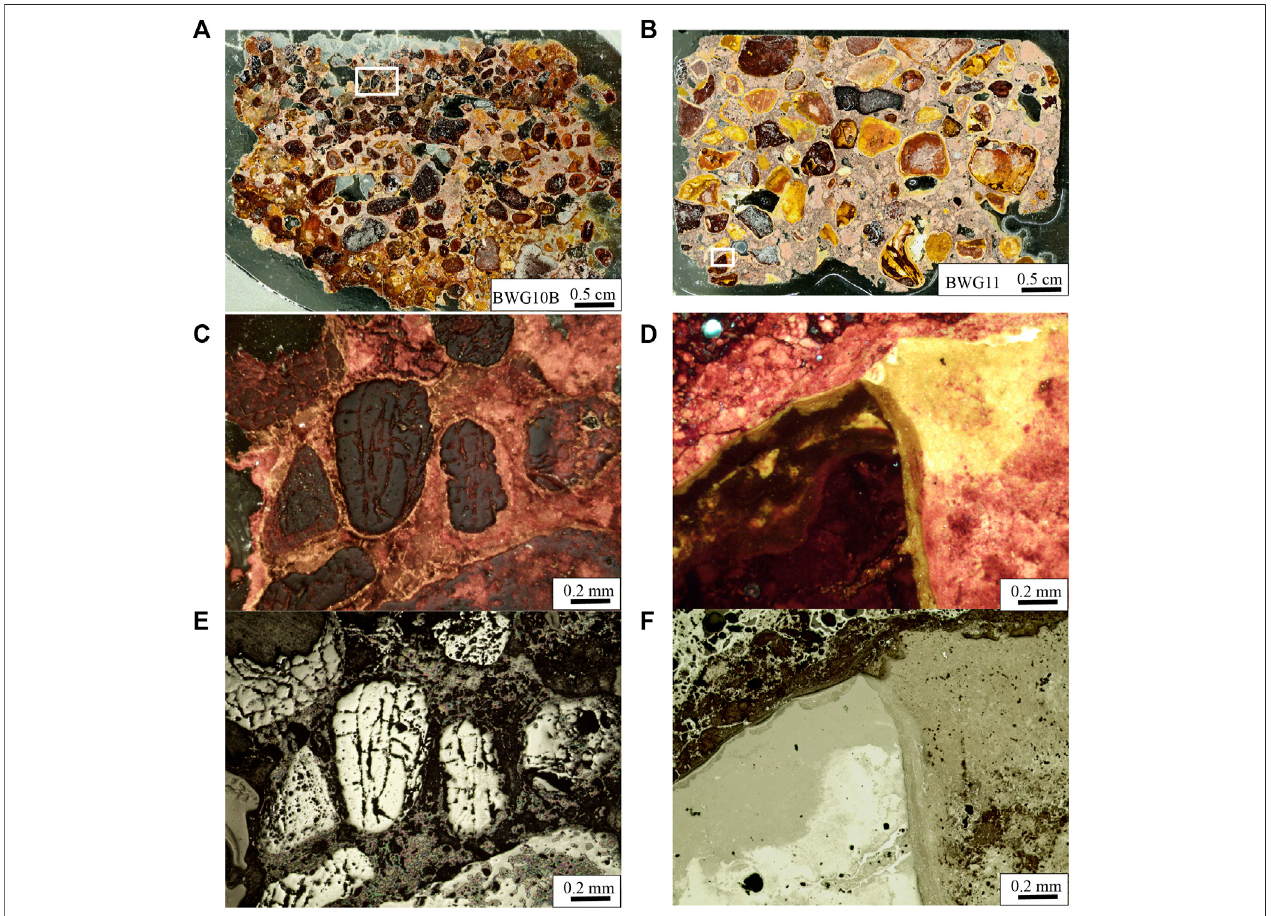
FIGURE 3 | Optical micro-photograph of thin sections of (A) BWG10B duricrust and (B) BWG11 duricrust, illustrating the Fe-oxide distribution. Magni fi ed view of BWG10B (C) showsmultipleFe-oxidegrainsthatlookhomogenousunderre fl ectedlight (E) ,whileforBWG11 (D) ,geochemicalheterogeneitiescanbeobservedwithin a single isolated grain (F)